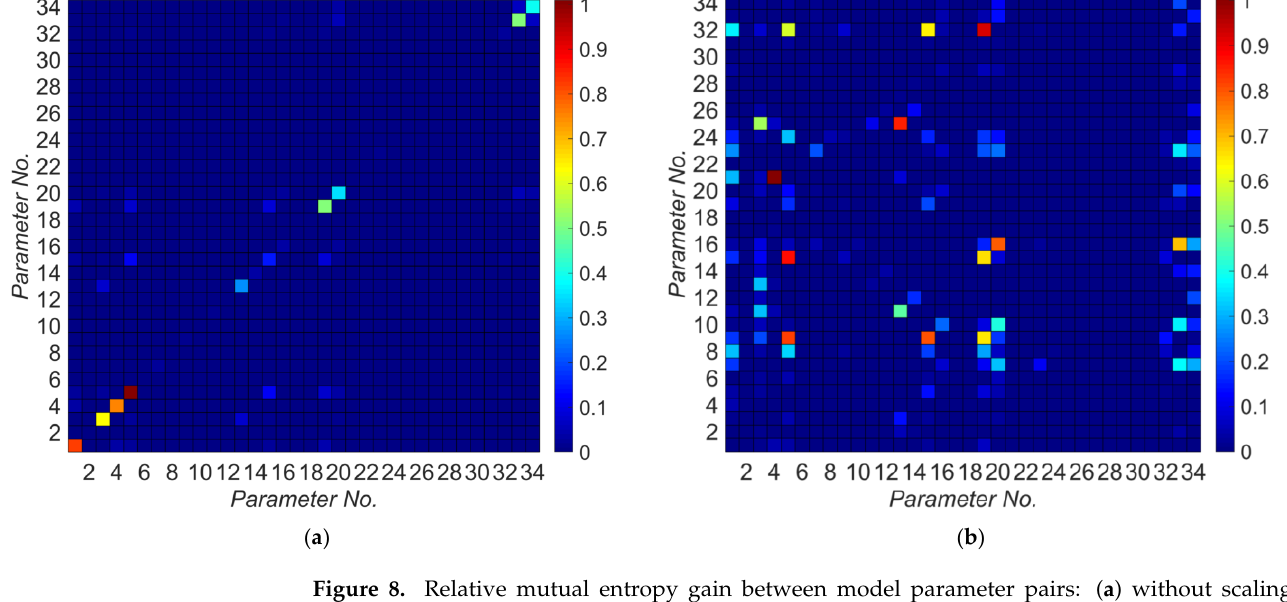
Figure 8. Relative mutual entropy gain between model parameter pairs: ( a ) without scaling, ( b ) with scaling.